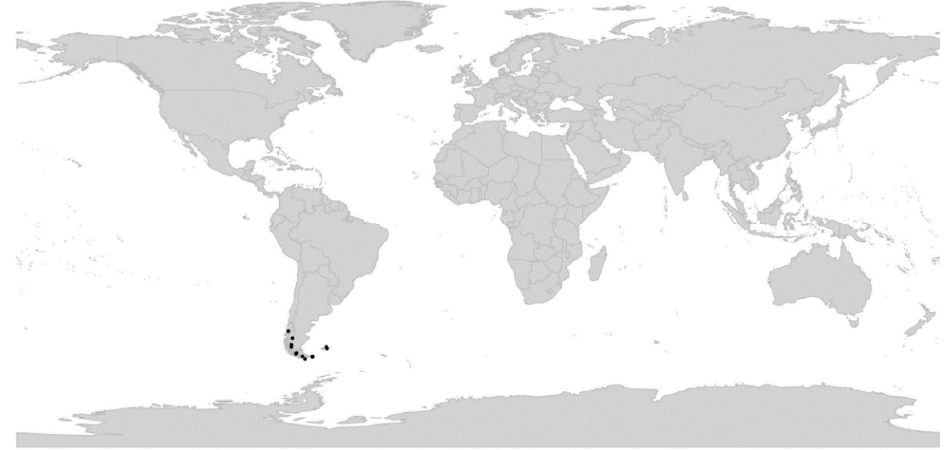
Figure 31. Global distribution of Viola sect. Tridens .